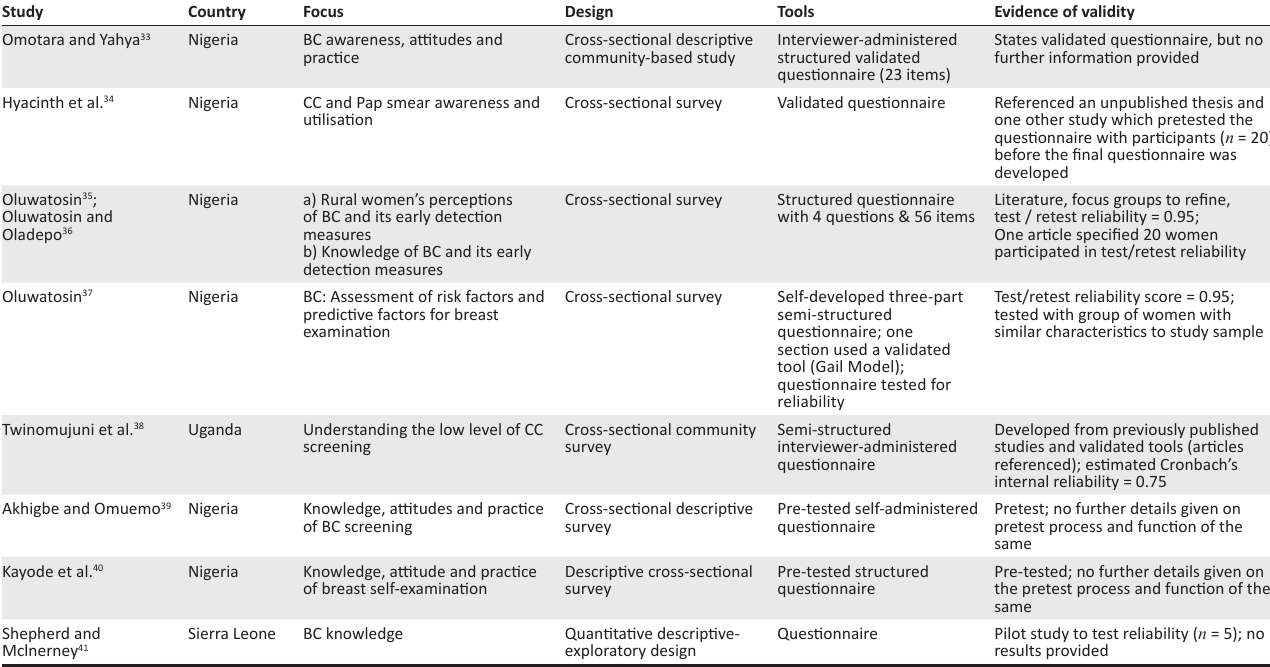
TABLE 2: Symptom awareness tools identified, some validation details